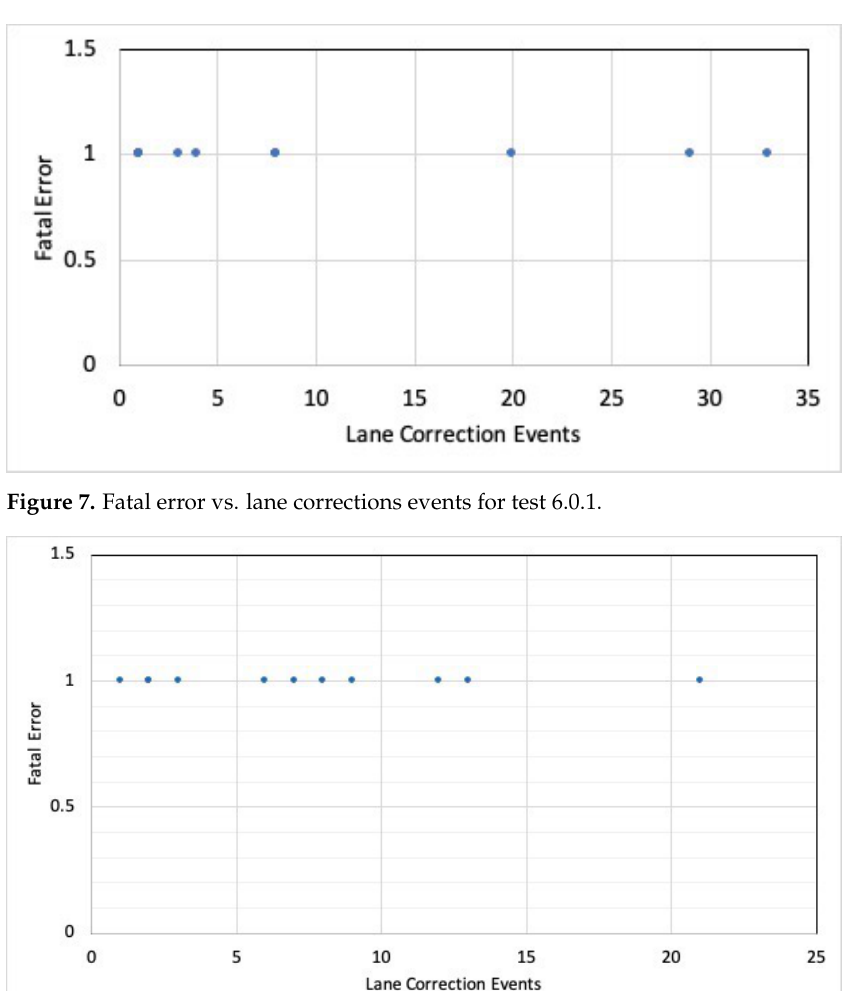
Figure 8. Fatal error vs. lane corrections events for test